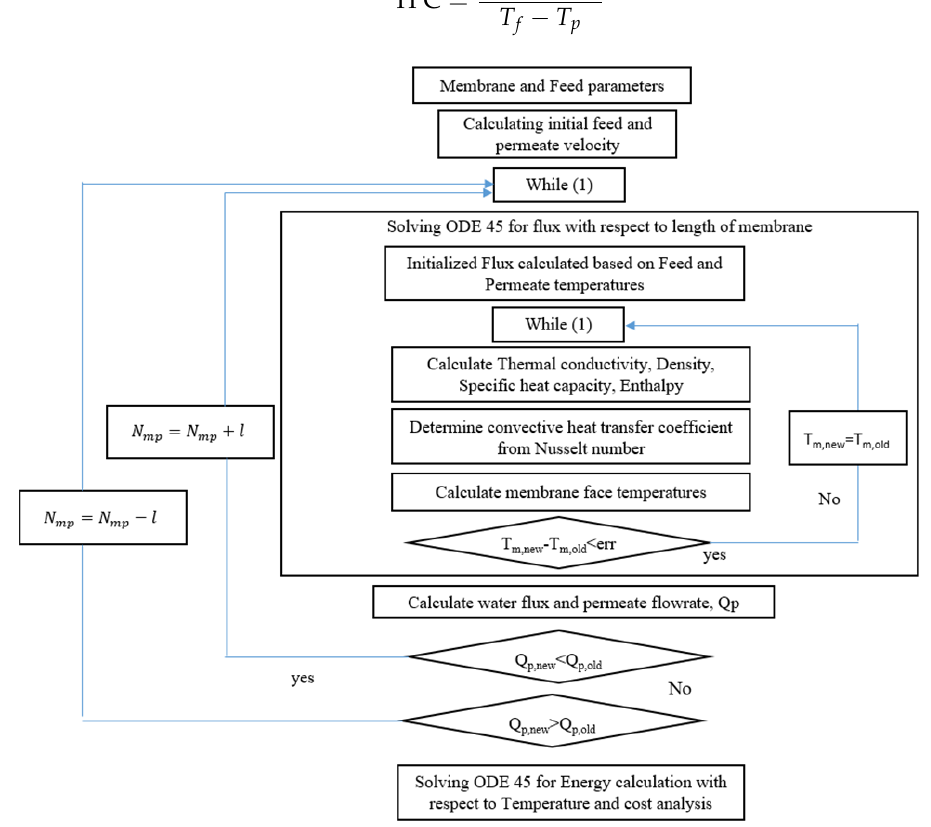
Figure 5. Design algorithm for the MD process.